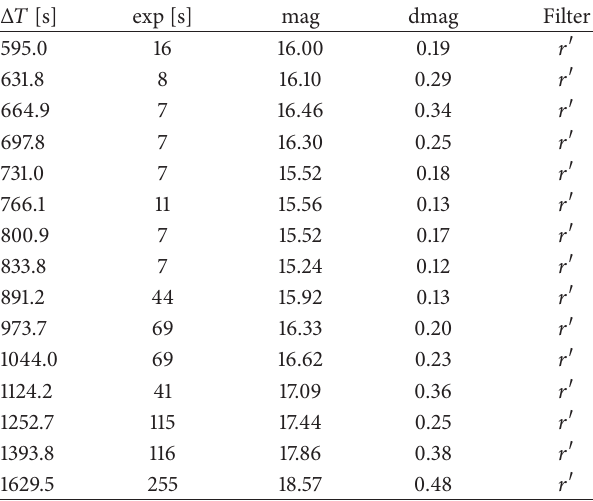
Table 11: GRB 101112A: observing log of